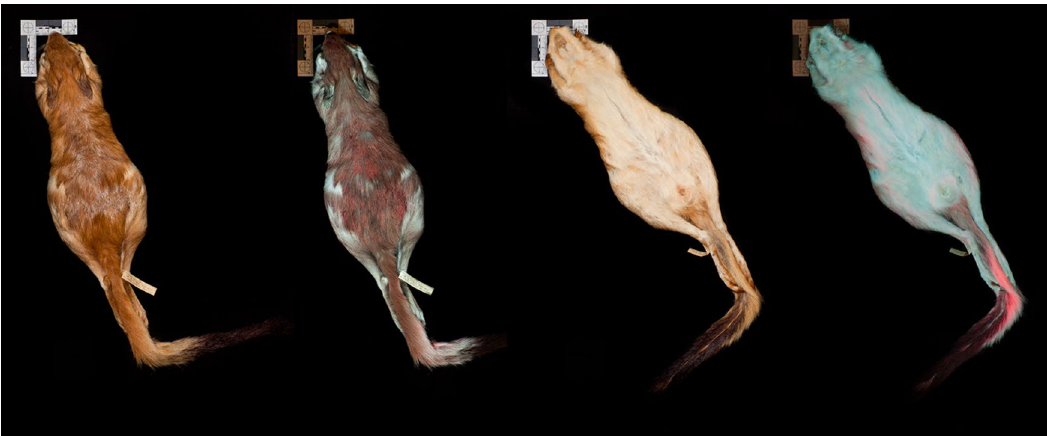
Figure 1. Biofluorescence in East African springhare museum specimens. A male Pedetes surdaster museum specimen (FMNH 73067) collected from the Central Province of Kenya in 1952, photographed under visible light (first and third image from left) and 395 nm ultraviolet light using a 470 nm longpass filter. Orange to red biofluorescence (~ 650 nm) is observed on the dorsal (leftmost images) and ventral surfaces (rightmost images) of this museum specimen from the Field Museum of Natural History (FMNH) in Chicago, Illinois,